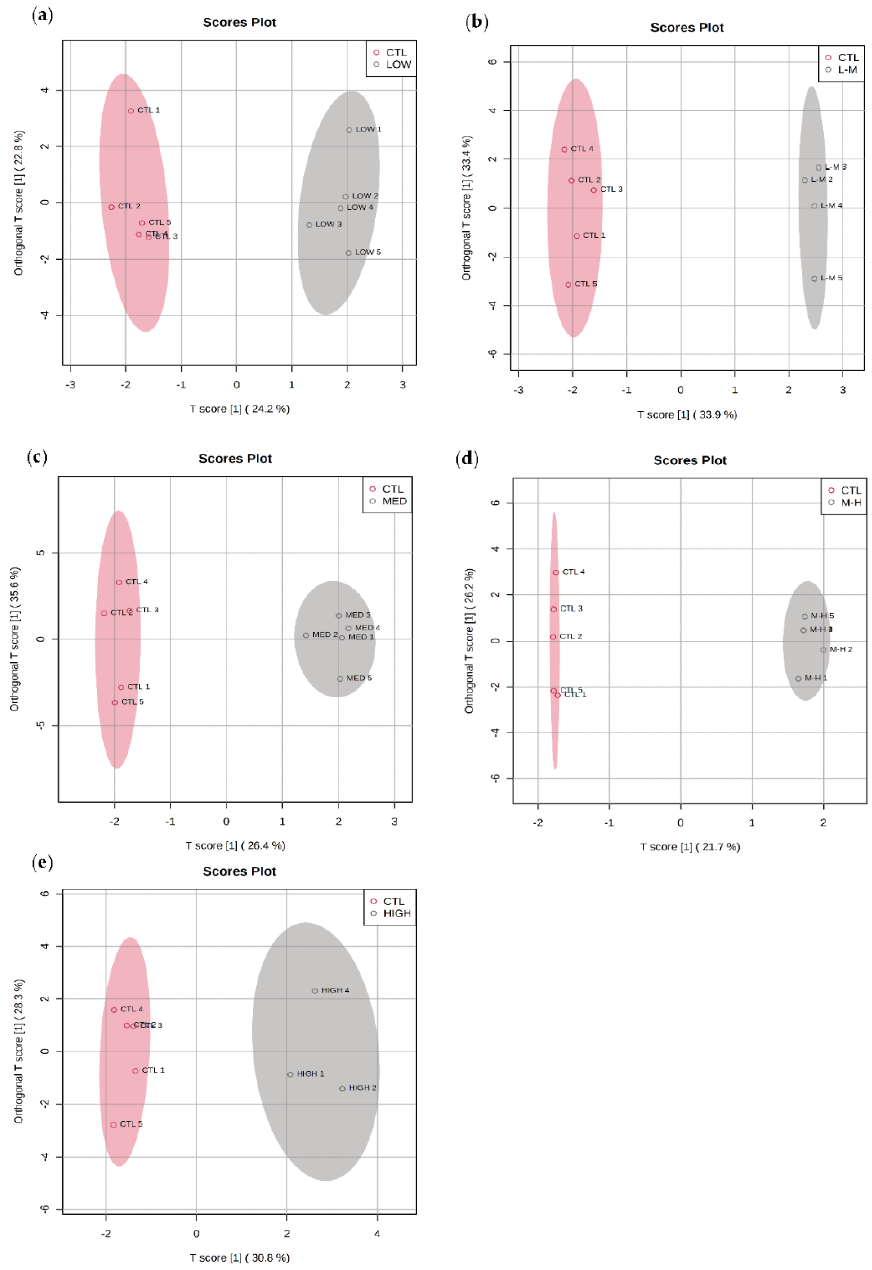
Figure 4. Orthogonal PLS-DA: separation of polar metabolites from amphipods exposed to GenX for 7 days at ( a ) low (0.03 µ g/L), ( b ) low–medium (0.16 µ g/L), ( c ) medium (0.80 µ g/L), ( d ) medium–high (4.00 µ g/L) and ( e ) high (20.00 µ g/L) concentrations. Orthogonal PLS-DA Model overview can be found in Supplementary Materials (Figures S7 – S11).